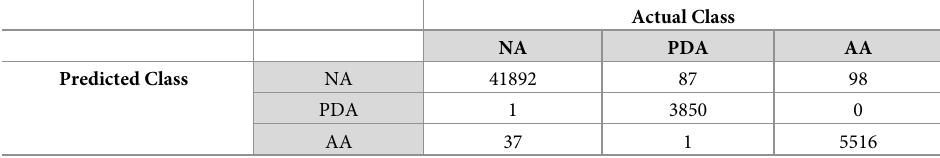
Table 1. Confusion matrix for predicted and actual ROI classes. Mean classification error = 0.44% (CI = 0.41– 0.45%) estimated from RF training repetitions on the test dataset (51482